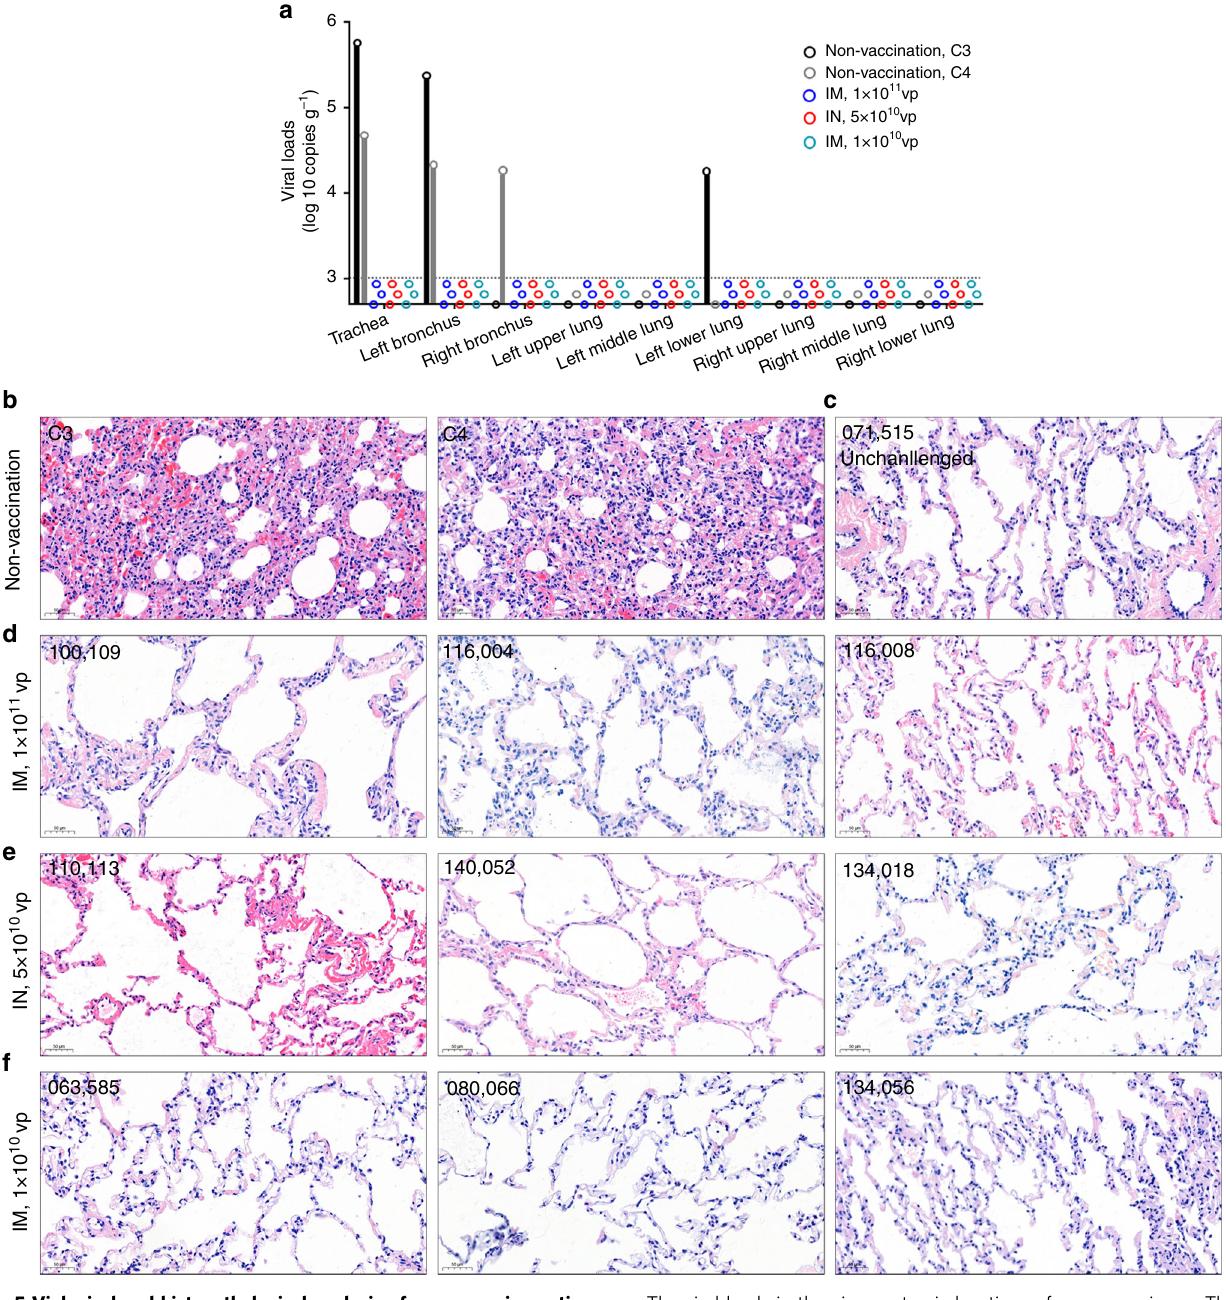
Fig. 5 Viological and histopathological analysis of macaque airway tissues. a The viral loads in the nine anatomic locations of macaque airway. The tissues of trachea, left and right bronchus, and the upper, middle, and lower locations of the left and right lung were collected at euthanasia. The viral genomes in the tissue homogenates were assessed by qRT-PCR. All the data points represent the mean values of two technical replicates. The dot line indicates the limit of detection (1000 copies per g tissue). b – f Histopathological changes in the lungs of SARS-CoC-2 challenged non-vaccinated macaques ( b ) and vaccinated macaques ( d – f ), and an unchallenged macaque IM vaccinated with 1 × 10 10 vp Ad5-S-nb2 ( c ). The lung tissue sections were stained with hematoxylin and eosin (H&E). One representative graph from each macaque is shown. Scale bars are 50 μ m and indicated in each panel. Source data are provided as a Source Data fi